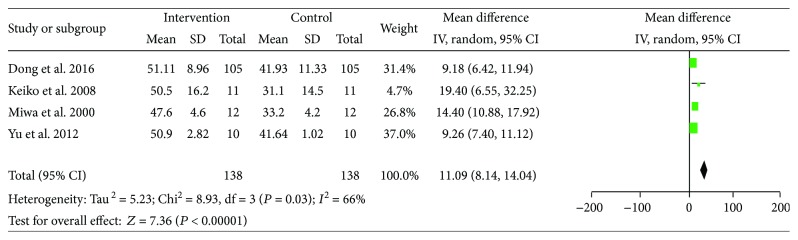
Forest plot for CHO%.